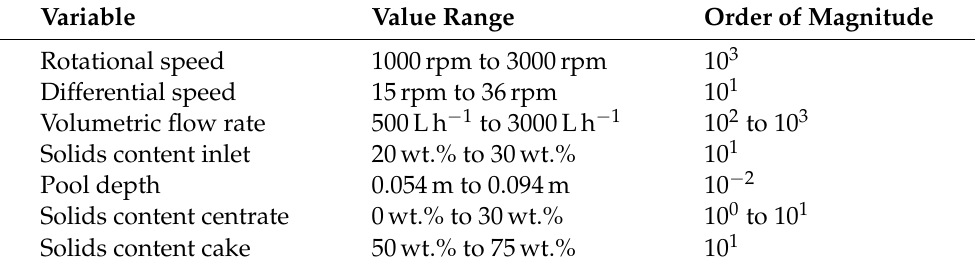
Table 1. Value range and order of magnitude of used data